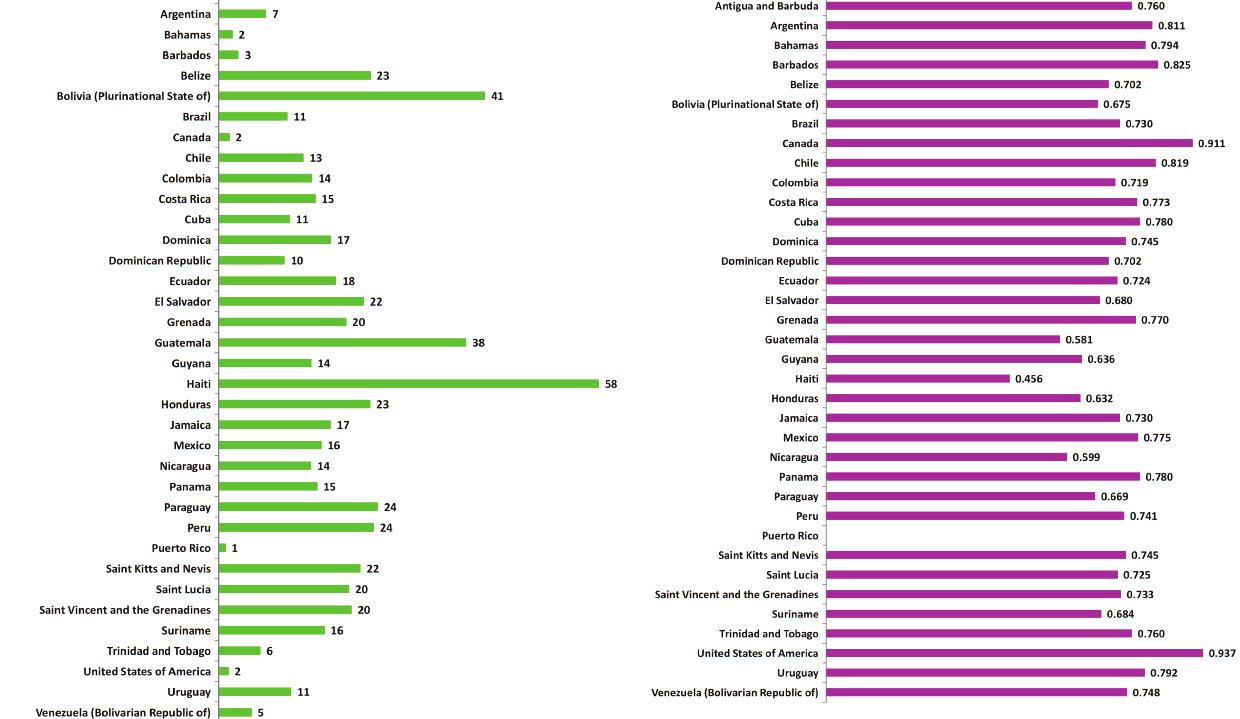
Figure 3: Total economically active population in agriculture to total economically active population (%) in 2011